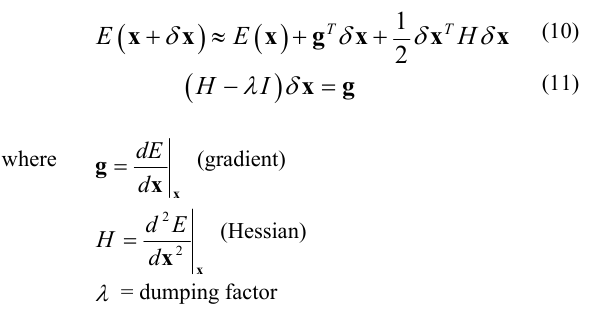
Figure 14. Linear regression between distance and α